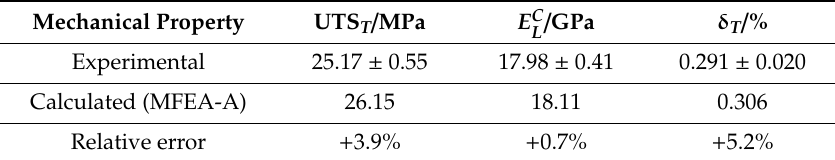
Table 8. Experimental and calculated mechanical properties under transverse tensile loading.